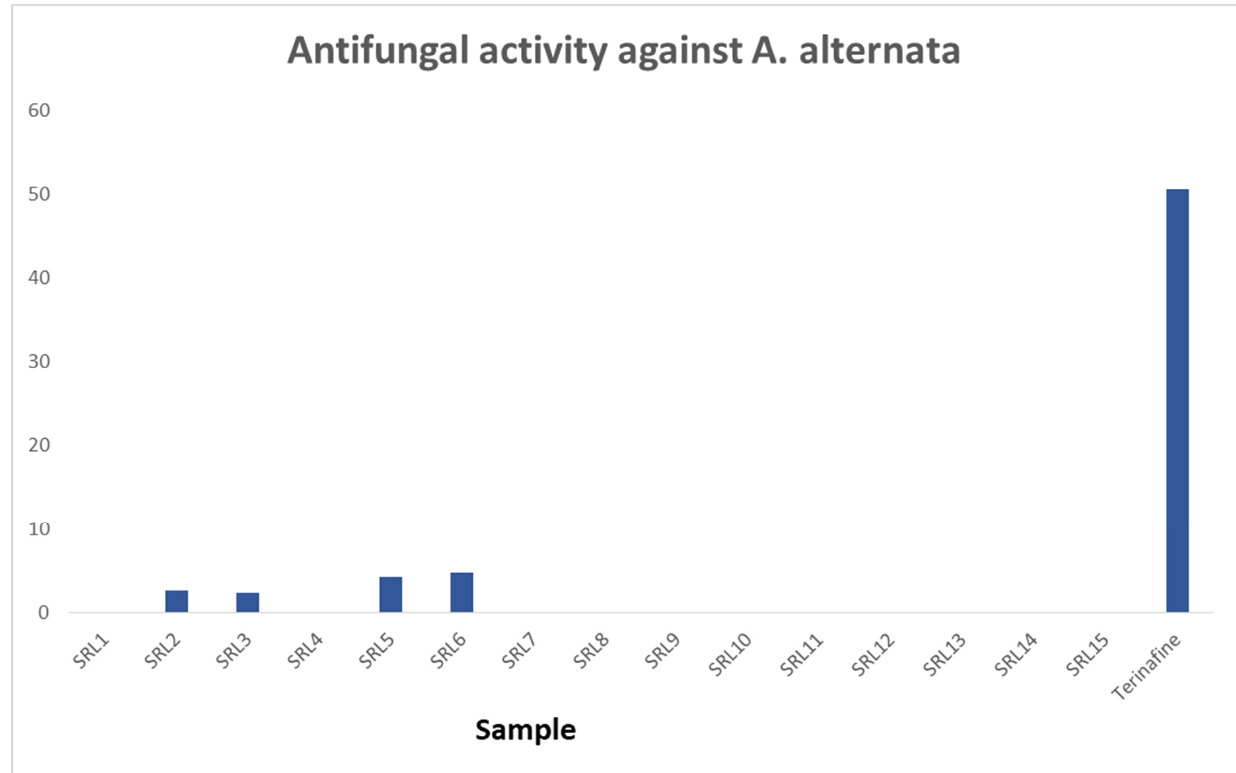
Figure 2. The anti-bacterial activity of scaffolds 1–15.